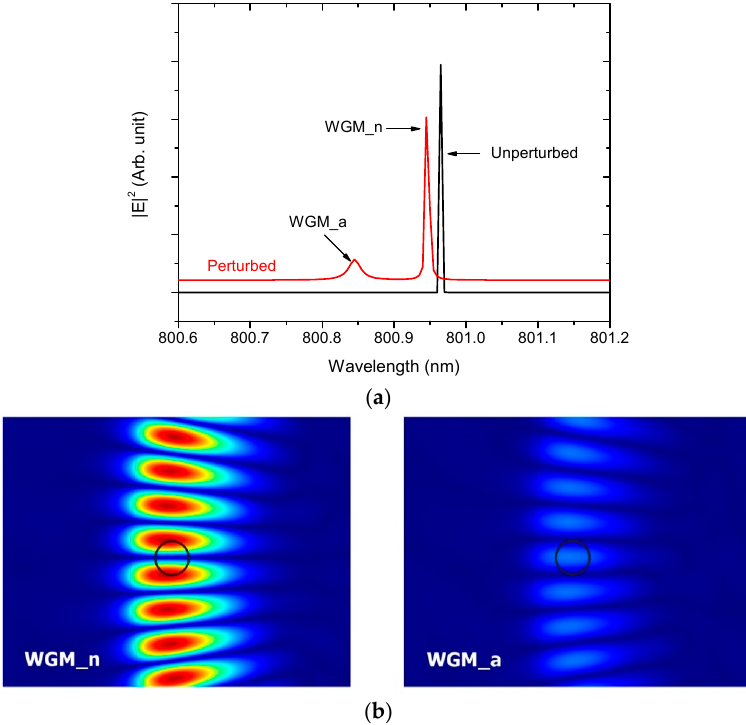
Figure 2. (Color online) ( a ) Representative spectra of the whispering gallery mode (WGM) resonances (unperturbed and perturbed by a nanocylinder of 50 nm in radius). The spectra are displaced vertically for clarity; ( b ) Electric field distributions at the position of the nanocylinder (100 nm in radius) for the two split WGMs.